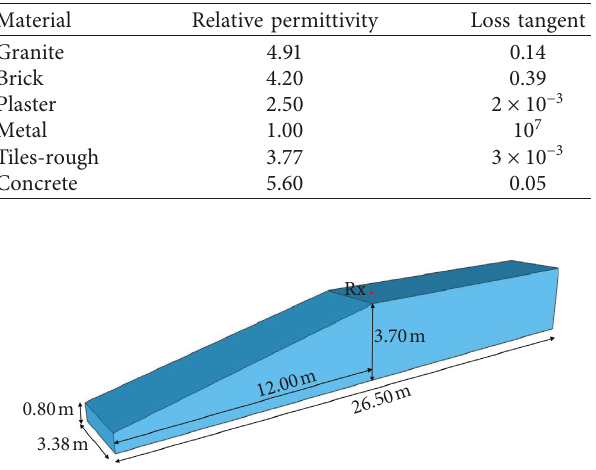
Figure 2: High-speed train model